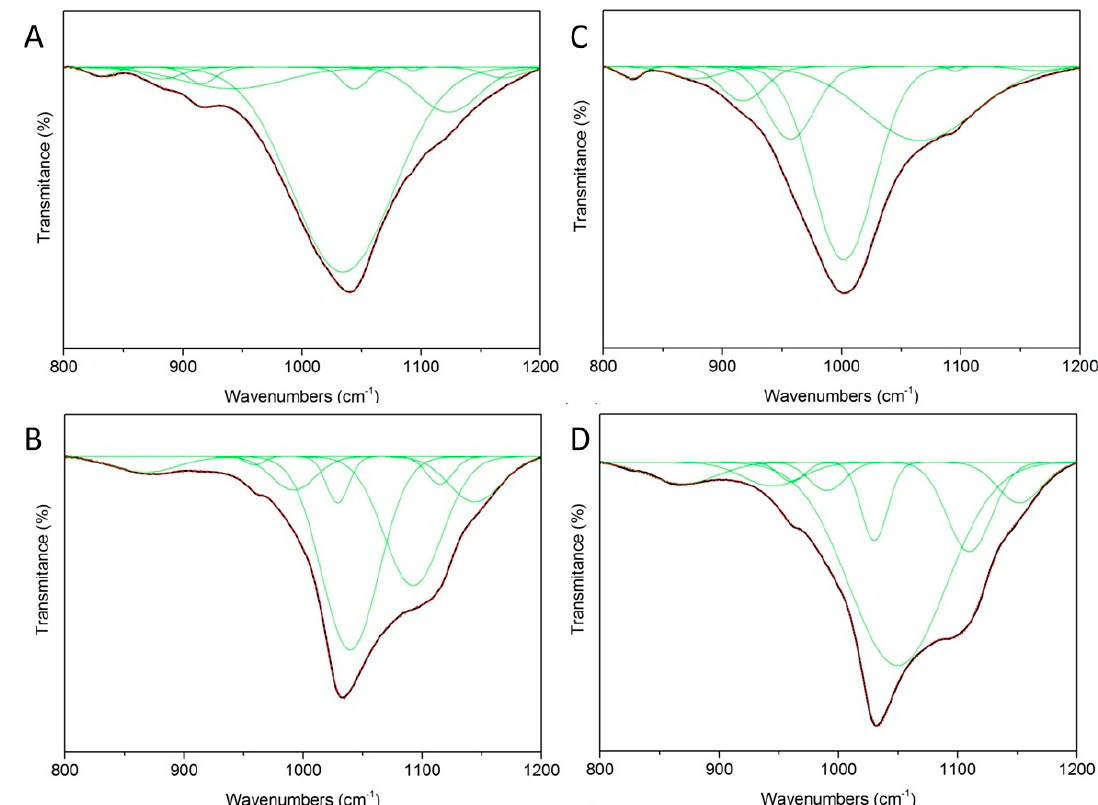
Figure 5. Deconvoluted FTIR spectra of ( a ) MCA, ( b ) VCA, ( c ) MCAH and ( d ) VCAH (experimental curve: black, calculated curve: red dash, sub ‐ bands: green).